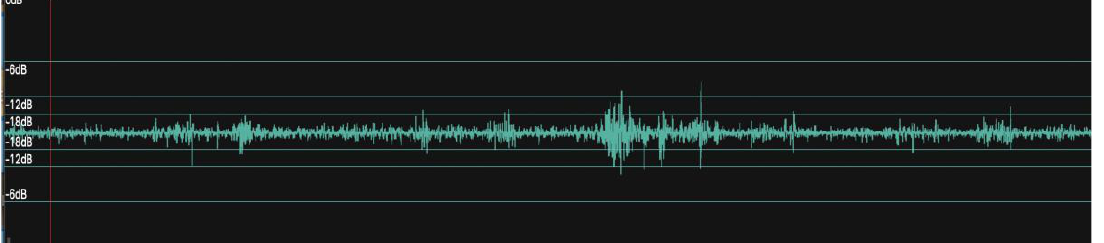
Figure 1. An example of our own rumen sound recording (Cow #1) made using a CURO MkII wireless system (CURO-Diagnostics ApS, Bagsværd, Denmark) operating Bluetooth 4 and interacting with a recording device remotely. Sampling rate 2 kbps, gain 32 dB. This dataset represents short samples of a longer 34-min recording. Rumen sounds were measured on the decibel (dB) scale. Note the occasional bursts of rumen sounds with relatively long periods of little to no rumen sounds in between them.